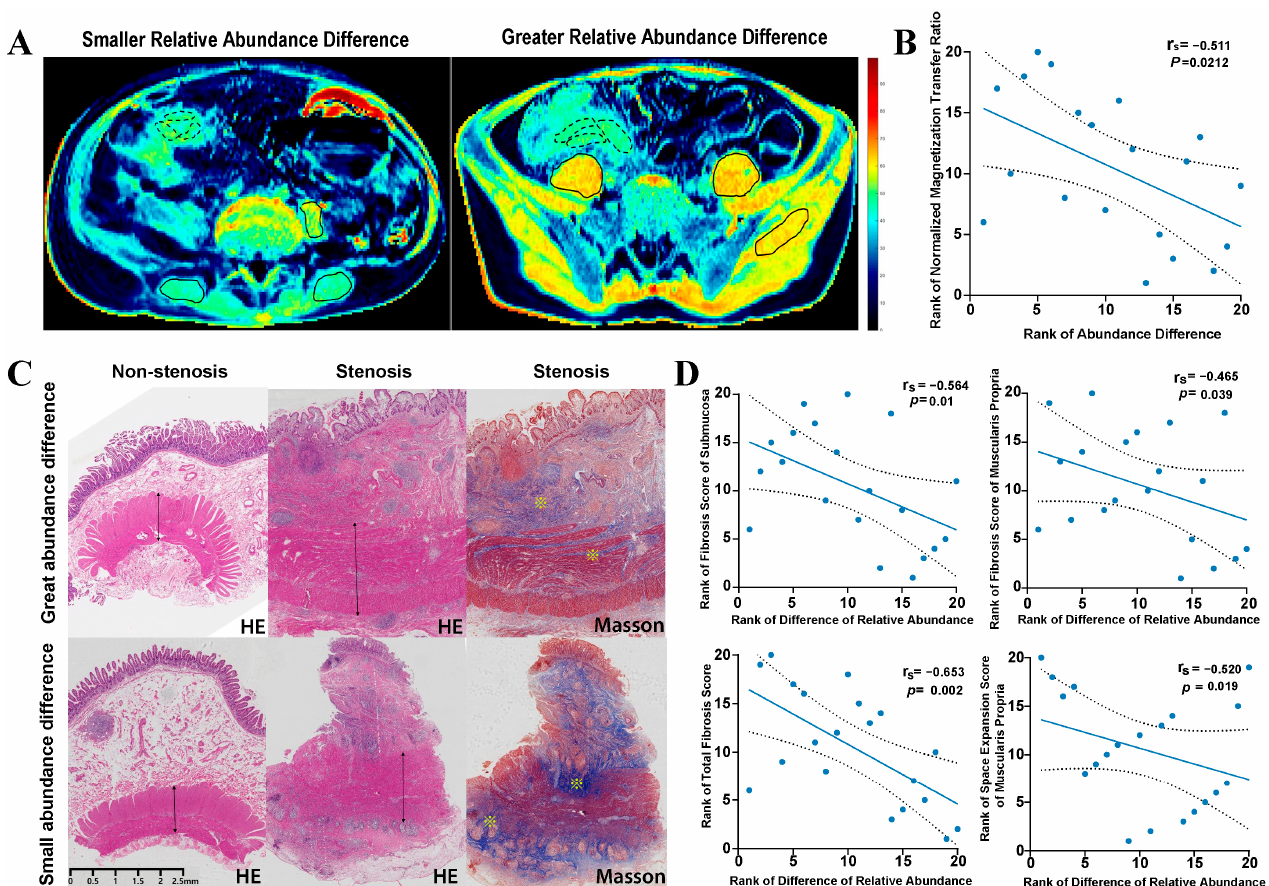
Figure 4. Correlations between Genus Oscillospira sp. abundance difference (stenotic site vs. non- stenotic site) and the degree of intestinal fibrosis. Patients with great and small Oscillospira sp. abundance differences were presented respectively. ( A ): Representative illustration showed the measurement of the normalized MT ratio of the affected bowel wall. Tissues with high MT ratios (such as skeletal muscle) appear yellow-red, while tissues with low MT ratios (such as subcutaneous fat) are dark blue. Normalized MT ratio of bowel wall was measured as MT ratios of the bowel wall (delineated by )/MT ratios of muscle (delineated by ); ( B ): Spearman’s rank correlation analysis between Oscillospira sp. abundance difference and normalized MT ratio of bowel wall; ( C ). Representative intestinal histopathological characteristics of stenotic and non-stenotic sites in the same patient. ↔ indicated space volume of muscularis propria layer; ※ indicated increased collagen deposition in submucosa and muscularis propria layers. ( D ): Spearman’s rank correlation analysis between Oscillospira sp. abundance di ff erence and fi brosis score and space volume expansion score. 3.4. Mucosa-Associated Oscillospira sp. in the Residual Intestine Contributed to the Maintenance of Disease Remission Given that the genus Oscillospira sp. was identi fi ed as the most distinguishing microbe between the stenotic sites and non-stenotic sites, we considered the relationship between this genus and postoperative disease recurrence. We measured the relative abundance of the genus Oscillospira sp. in non-stenotic sites and in the residual intestine. According to the relative abundance of Oscillospira sp., patients with CD were equally divided into two groups: the low abundance group, containing nine patients with a relative abundance of Oscillospira sp. ranging from 0 to 0.021%; and the high abundance group, containing other eleven patients with a relative abundance ranging from 0.0381% to 4.6%. All patients were followed up to evaluate their postoperative course. Detailed